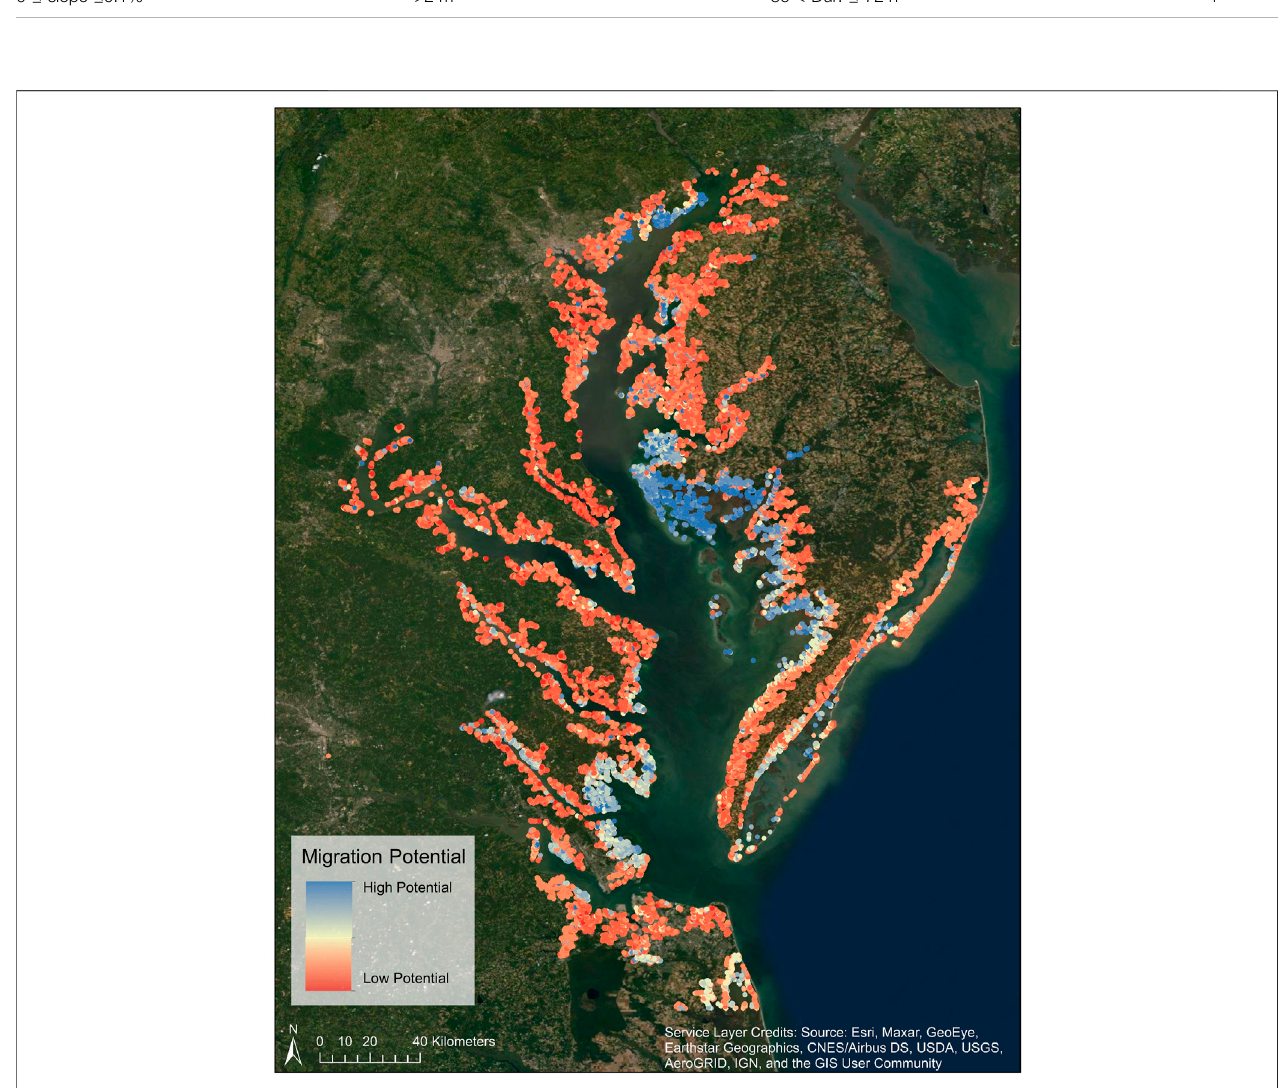
FIGURE 6 | Marsh migration potential in the Chesapeake Bay. Low scores indicated with red, high scores indicated with blue.